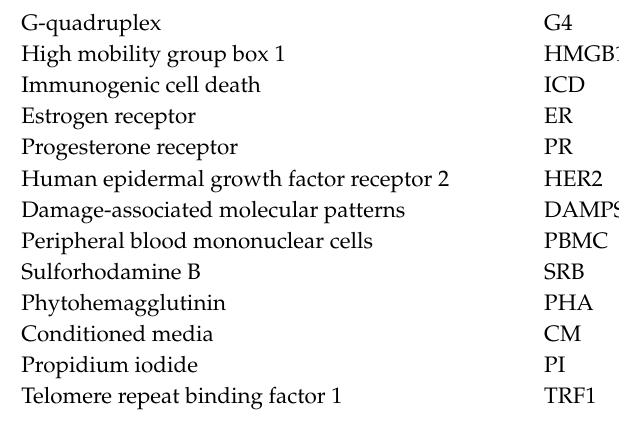
Figure S1: Cytotoxicity in MCF-10A, Figure S2: DNA damage in MCF-7 and MDA-MB231, Figure S3: Cell cycle progression in MCF-7 and MDA-MB231, Figure S4: Apoptosis in MCF-7 and MDA-MB231, Figure S5: ICD hallmarks in MCF-7 and MDA-MB 231 cells treated with G4